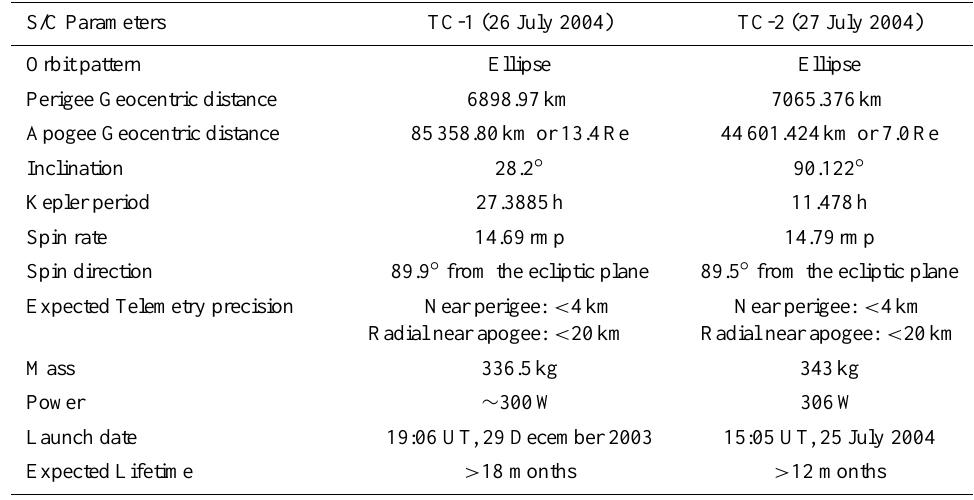
Table 1. Parameters of TC-1 and TC-2 after launch of TC-2.